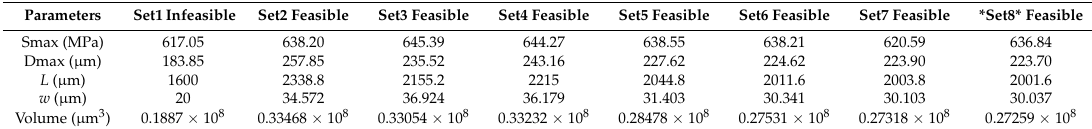
Figure 3. The structure of the V‑shape electro‑thermal actuator. Table 1. The optimized results.